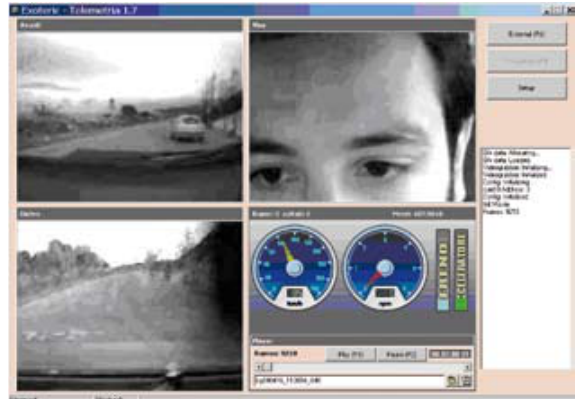
Fig. 1. Graphic interface of the 3 video cameras and the telemetry in real